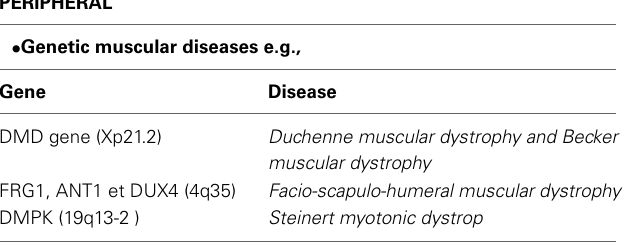
Table 2 | Genetics of